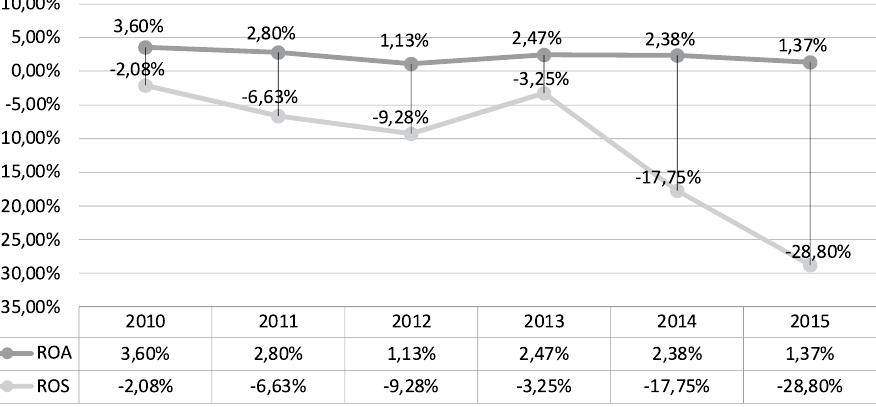
Figure 2. ROA & ROS: Companies Not Presented on Foreign Markets